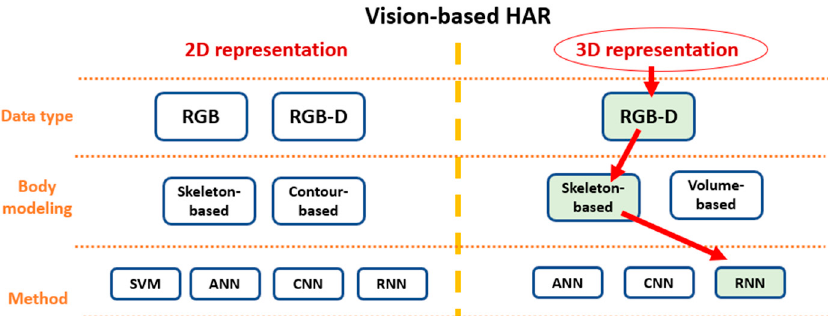
Figure 1. Vision-based HAR components classification based on the literature overview.